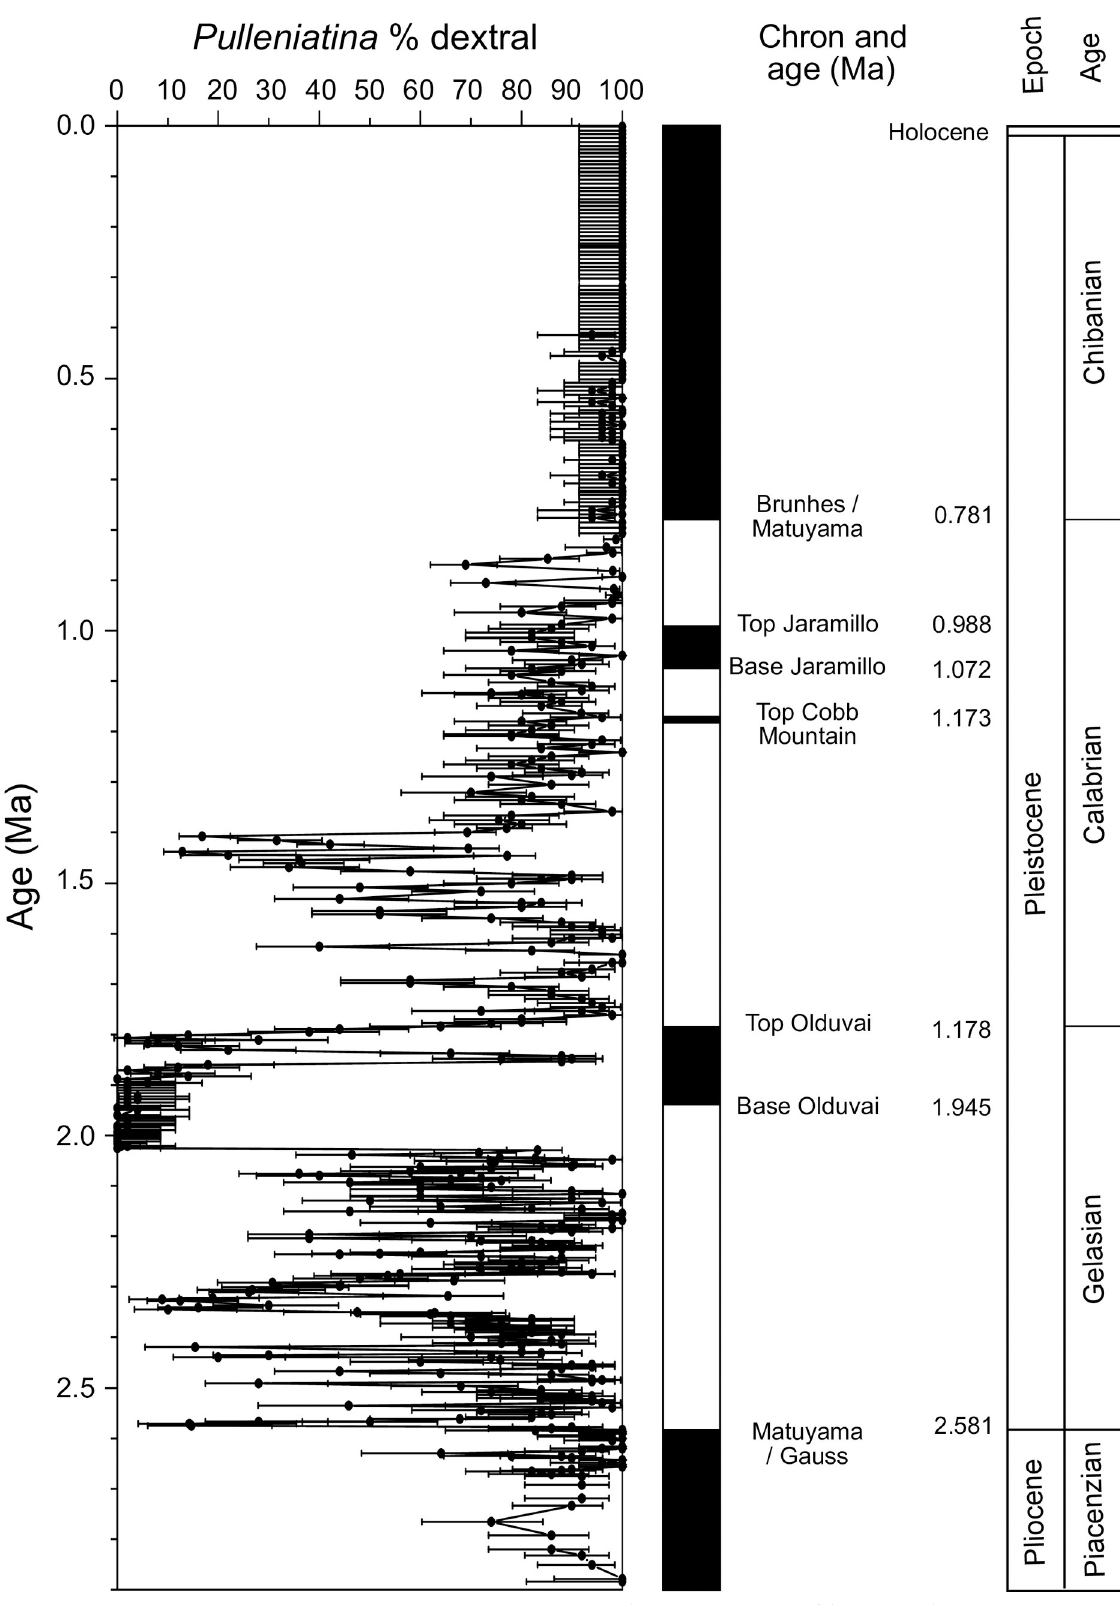
Fig 6. High resolution Pulleniatina coiling ratio record at Site U1486. Error bars represent 95% confidence intervals. https://doi.org/10.1371/journal.pone.0249113.g006 PLOS ONE | https://doi.org/10.1371/journal.pone.0249113 April 13,